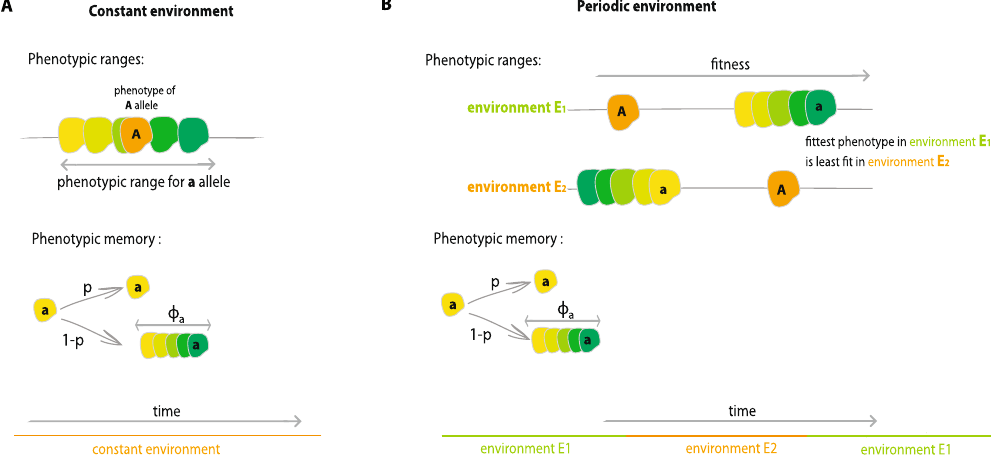
Figure 1. Illustration of model. ( A ) Constant environment. The population is initially fixed on allele A , which can express only one phenotype, Φ A . We determine the fate of a new mutant, a , which has access to a wider phenotypic range described by the random variable Φ a . Fitness is defined to equal phenotype, and both alleles have the same mean fitness:   Φ = Φ ( ) ( ) . For individuals of a genotype there exists a probability of A a phenotypic memory p , between parent and offspring: with probability p , the offspring keeps the same phenotypic state as its parent, while, with probability 1 − p , the offspring’s phenotype is determined as a new sample from Φ a . ( B ) Periodic environment. With environments changing, we assume that the phenotypes that are fitter in one environment are less fit in the other. Both alleles have the same mean fitness in their preferred environment: